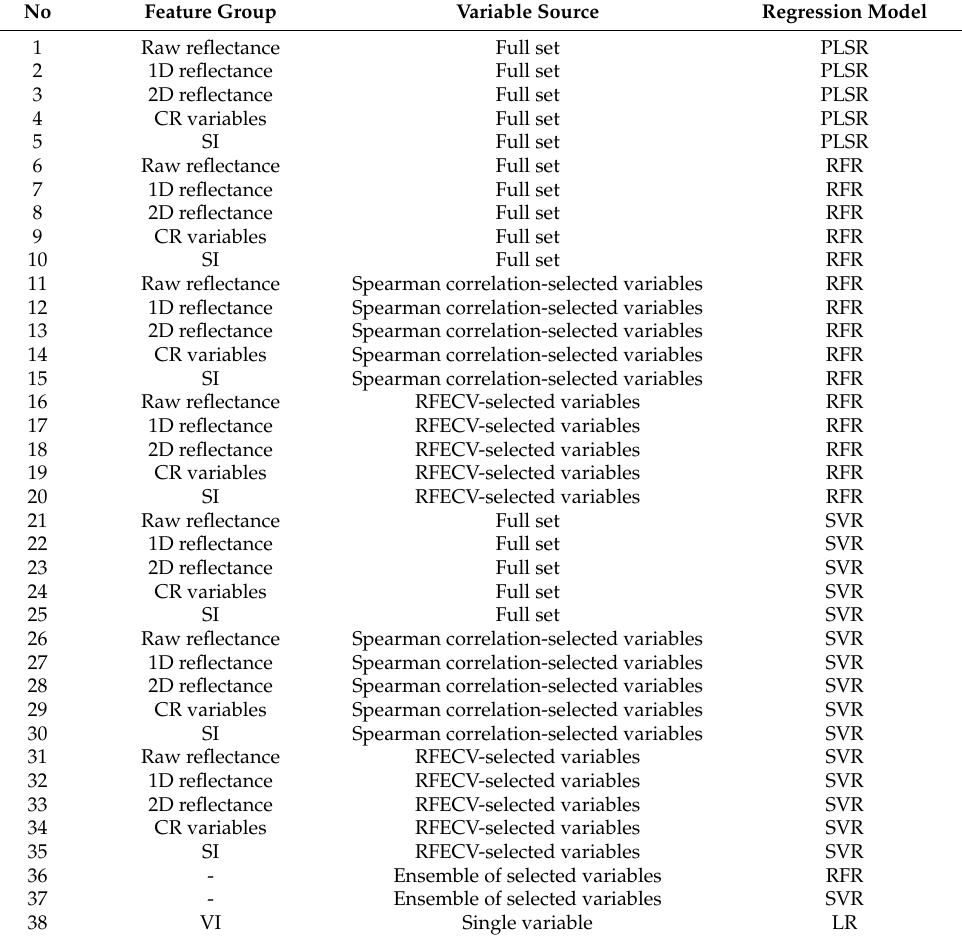
Table 4. The list of modeling